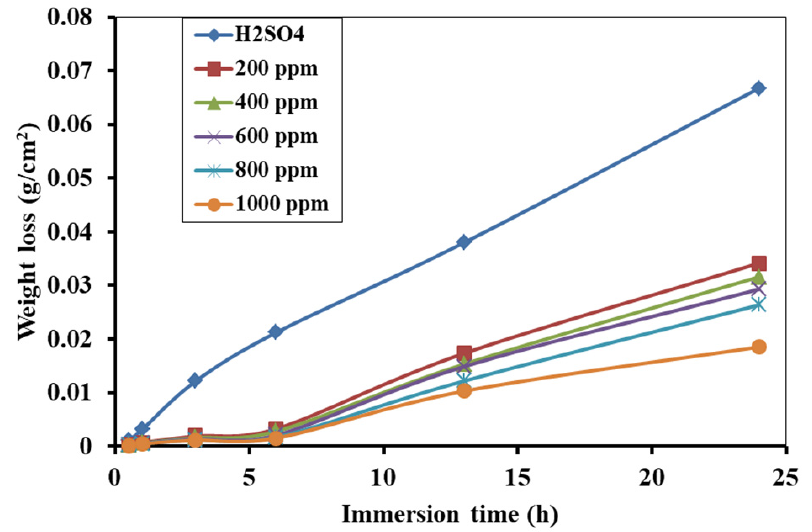
Figure 6. Weight loss of mild steel immersed in different concentrations of AV alkaloids at different intervals of time at 20 ° C.